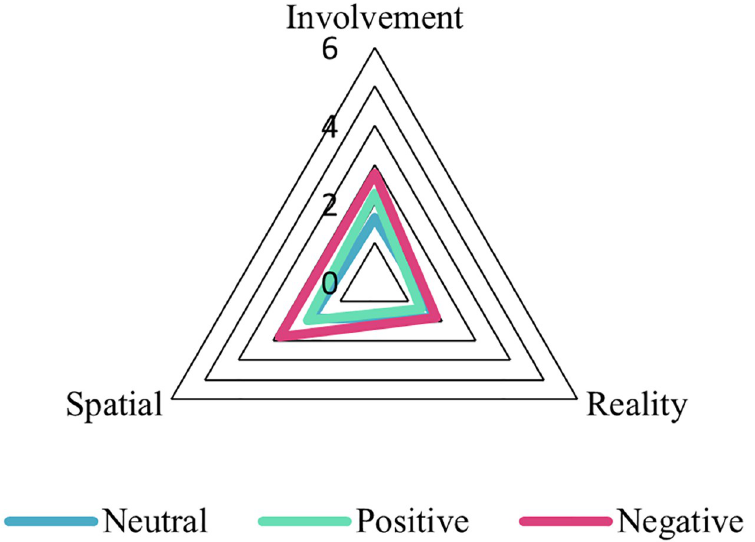
Fig 6. Radar plot showing average scores for each subscale: Involvement, spatial presence (‘Spatial’) and experience realism (‘Reality’) per VE. General presence is excluded. The surface generated from the subscales contributes to the average presence felt for each VE (Neutral (blue outline), Positive (green outline), Negative (pink outline). The negative VE shows greater presence than the other